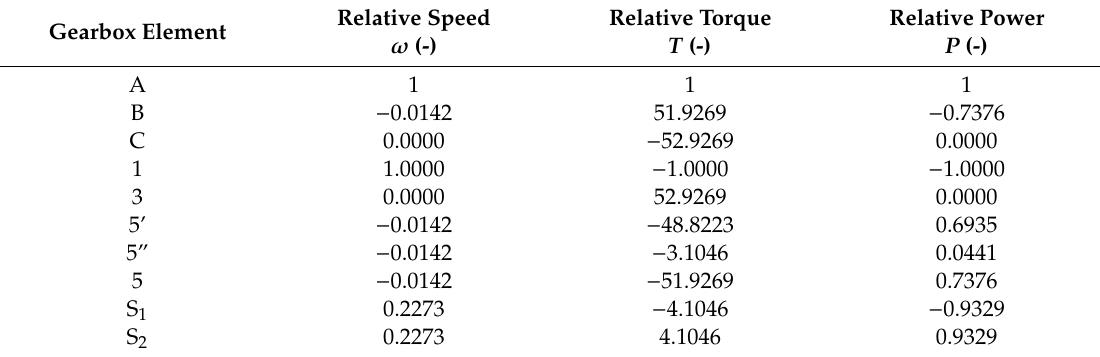
Table 2. Relative speeds, torques, and power at the partial elements of the calculated